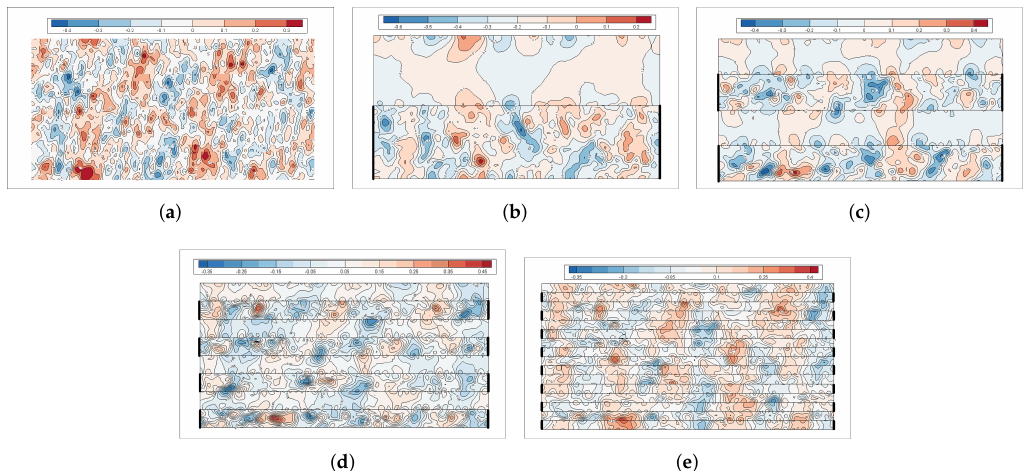
Figure 8. Contours of pressure distribution at the bottom wall of channel. ( a ) no-slip. ( b ) GF = 0.5, Strip number = 1. ( c ) GF = 0.5, Strip number = 2. ( d ) GF = 0.5, Strip number = 4. ( e ) GF = 0.5, Strip number = 8.